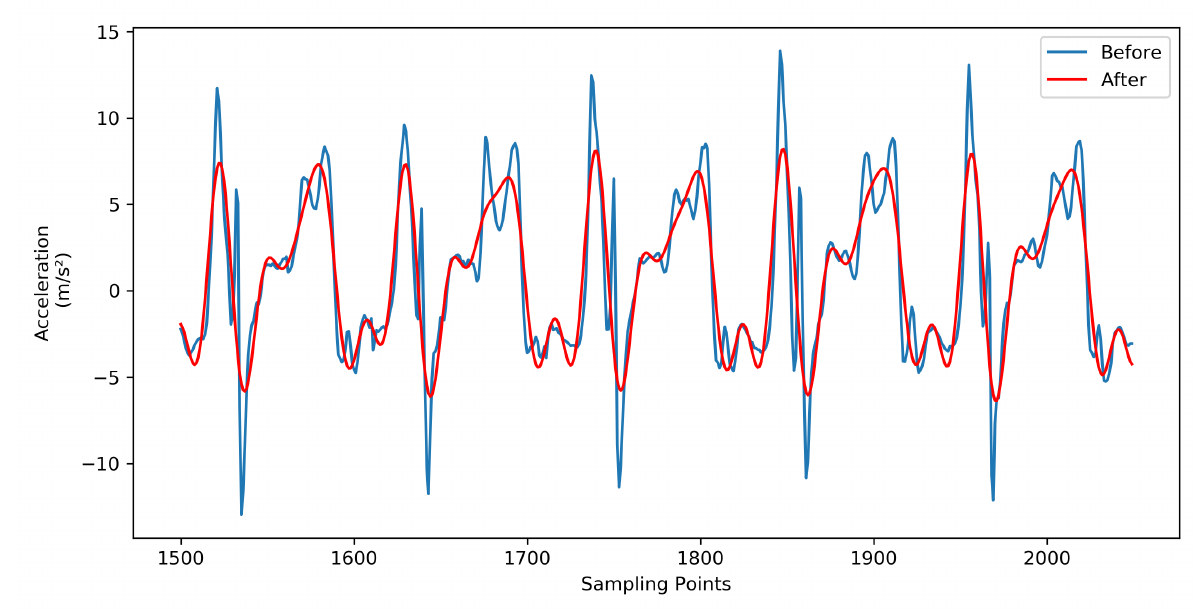
Figure 3. Comparison of gait signal before and after filtering. The human walking behavior is a regular quasi-periodic activity, starting from the first contact of the left foot with the ground to the alternation of the right foot until the left foot touches the ground again. Figure 4 shows a diagram of the human gait cycle.